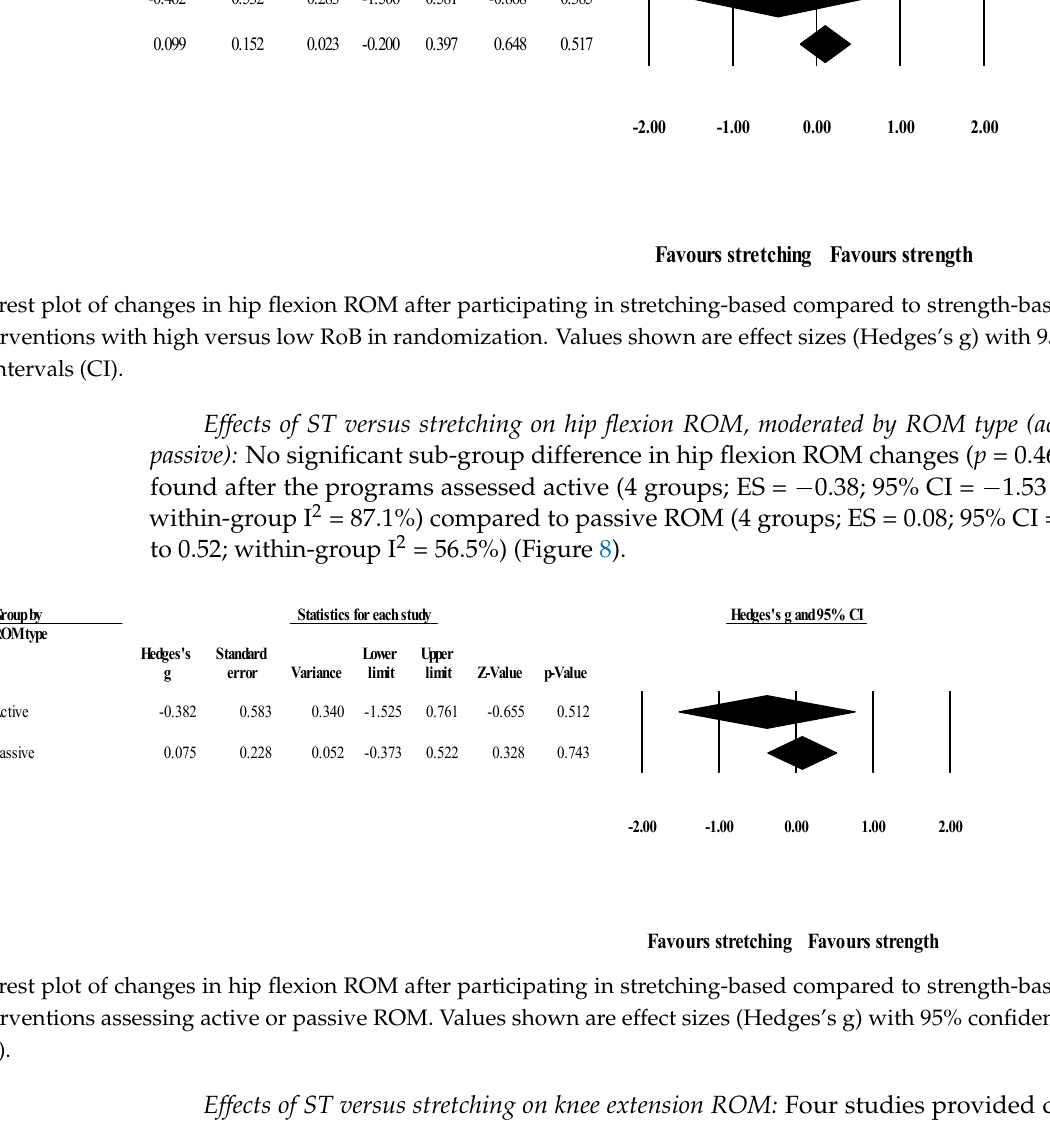
Figure 8. Forest plot of changes in hip flexion ROM after participating in stretching ‐ based compared to strength ‐ based training interventions assessing active or passive ROM. Values shown are effect sizes (Hedges’s g) with 95% confidence intervals (CI).